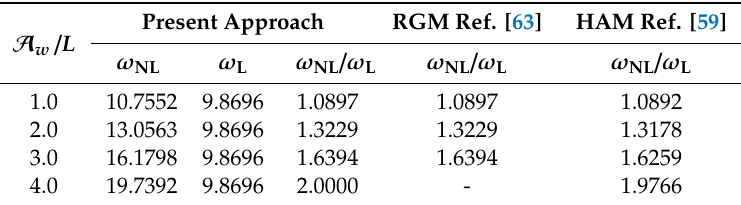
Table 4. Local nonlinear frequency ratios of perfect simply-supported (S-S) nano-beams ( λ = 0; A 0 = 0; (cid:101) K w = 0 )